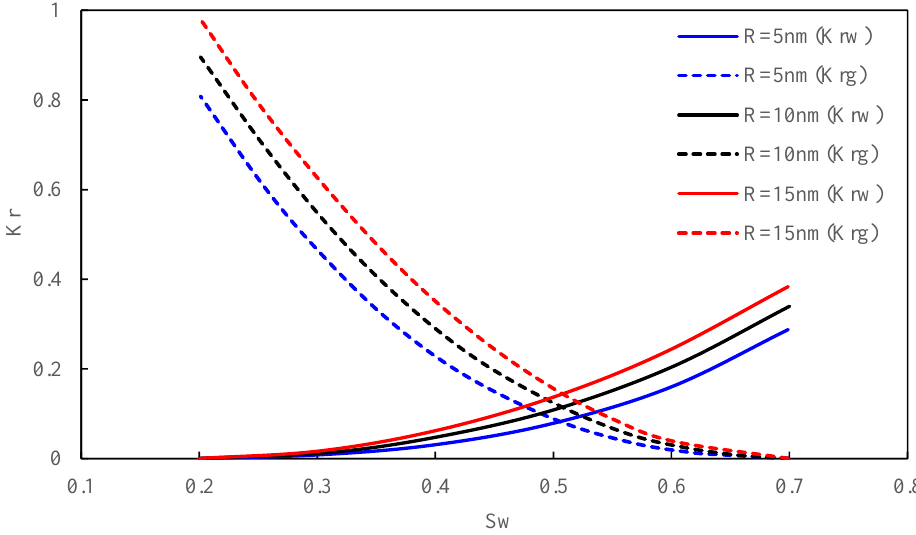
Figure 15. Relative permeability curves with different nanopore radii R [38].